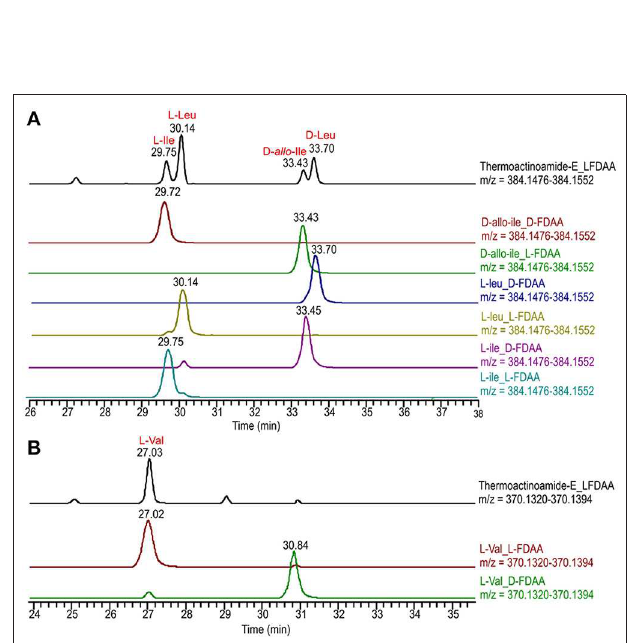
FIGURE 5 | Advanced Marfey’s analysis of compound 5 using a C18 reversed-phase column. (A) Extracted-ion chromatograms at m/z 384.1514 of the L -FDAA derivatives from the hydrolysis of 5 and of D - and L -FDAA derivatives L -Leu, L -Ile, and D - allo -Ile. (B) Extracted-ion chromatograms at m/z 370.1357 of the L -FDAA derivatives from the hydrolysis of 5 and of D - and L -FDAA derivatives L -Val.